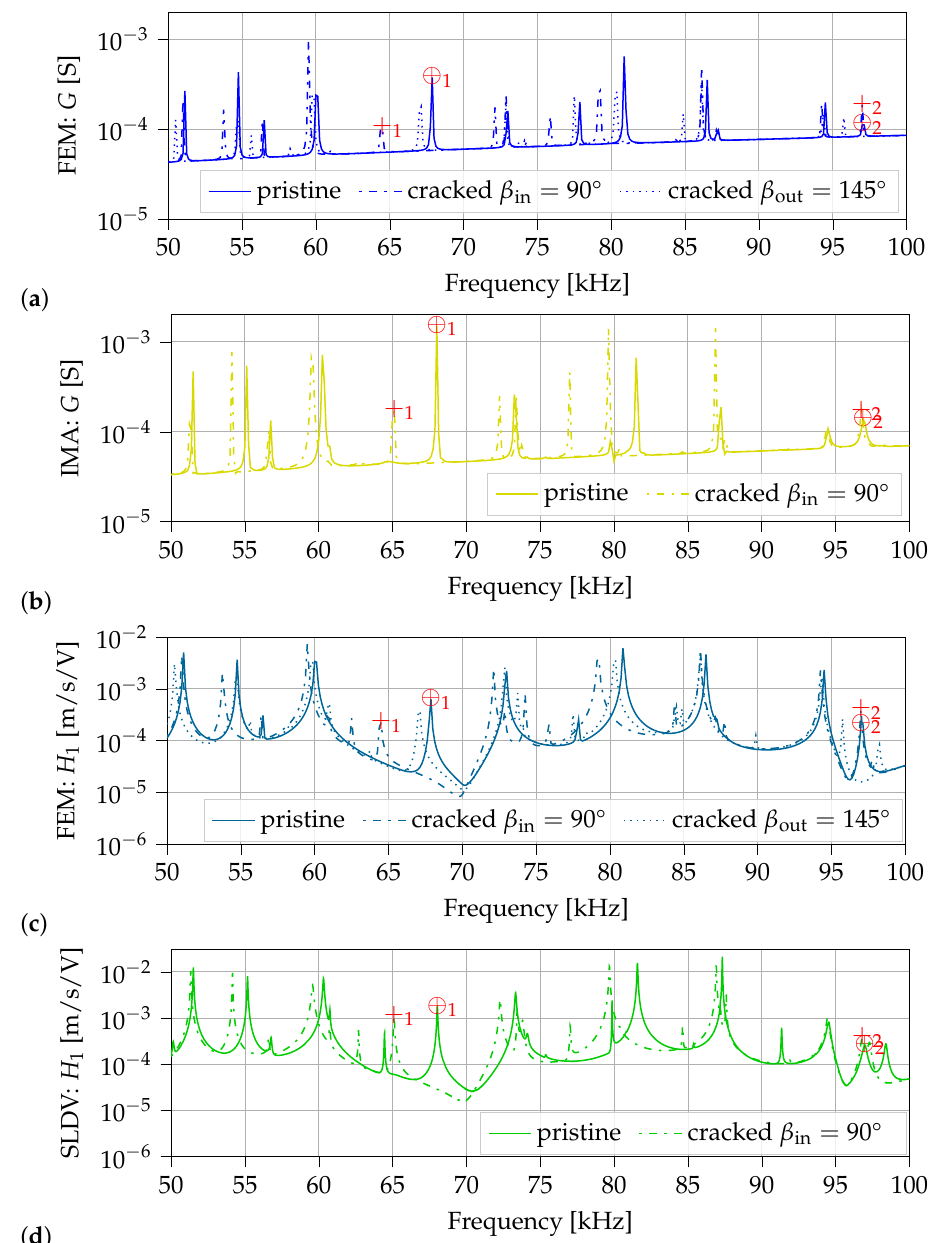
Figure 9. Spectra of pristine and damaged (cracks of length 2mm) necked lug of ( a ) conductance simulated with FEM; ( b ) conductance measured with the IMA; ( c ) mean out-of-plane vibration results simulated with FEM; ( d ) mean out-of-plane vibration results measured with the SLDV. Resonance frequency shifts ∆ f 1 and ∆ f 2 to identify the distinct crack location are highlighted with pristine spectra and with + 1,2 in spectra of the cracked lug ( a in = 2mm, β in =